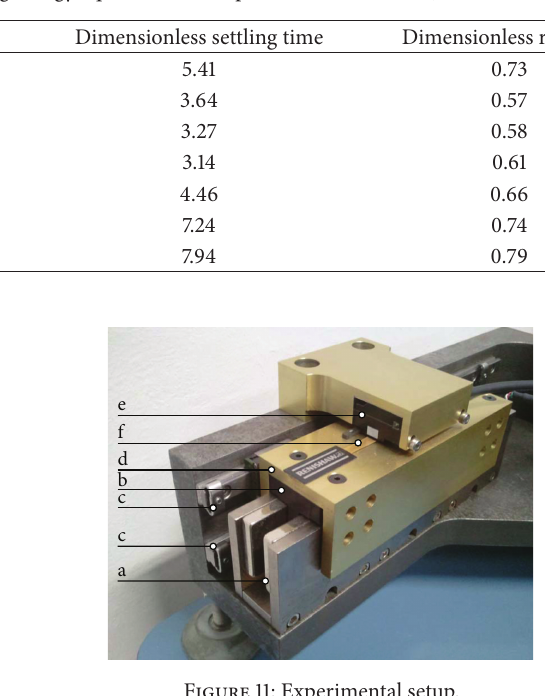
Table 2: 𝜁 - 𝜓 combinations with dimensionless settling energy equivalent to the pure PD control with 𝜁 = 1 .